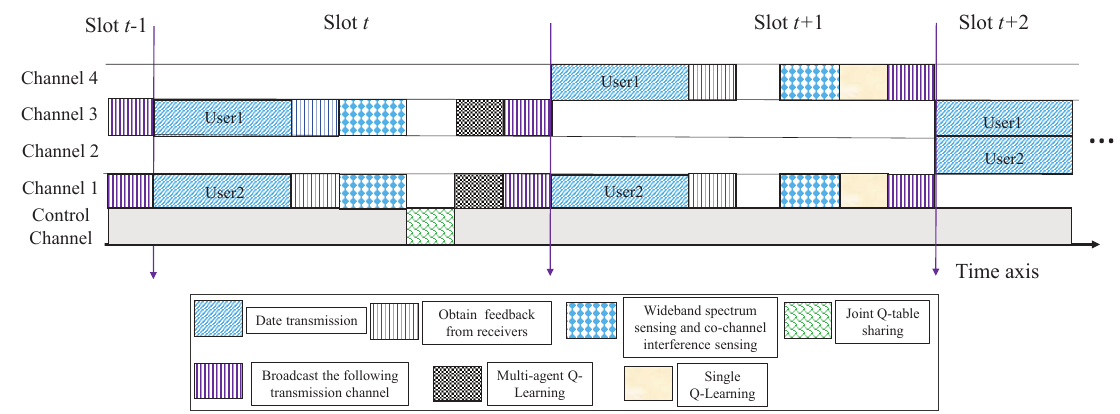
Figure 4. Anti-jamming transmission slot structure for